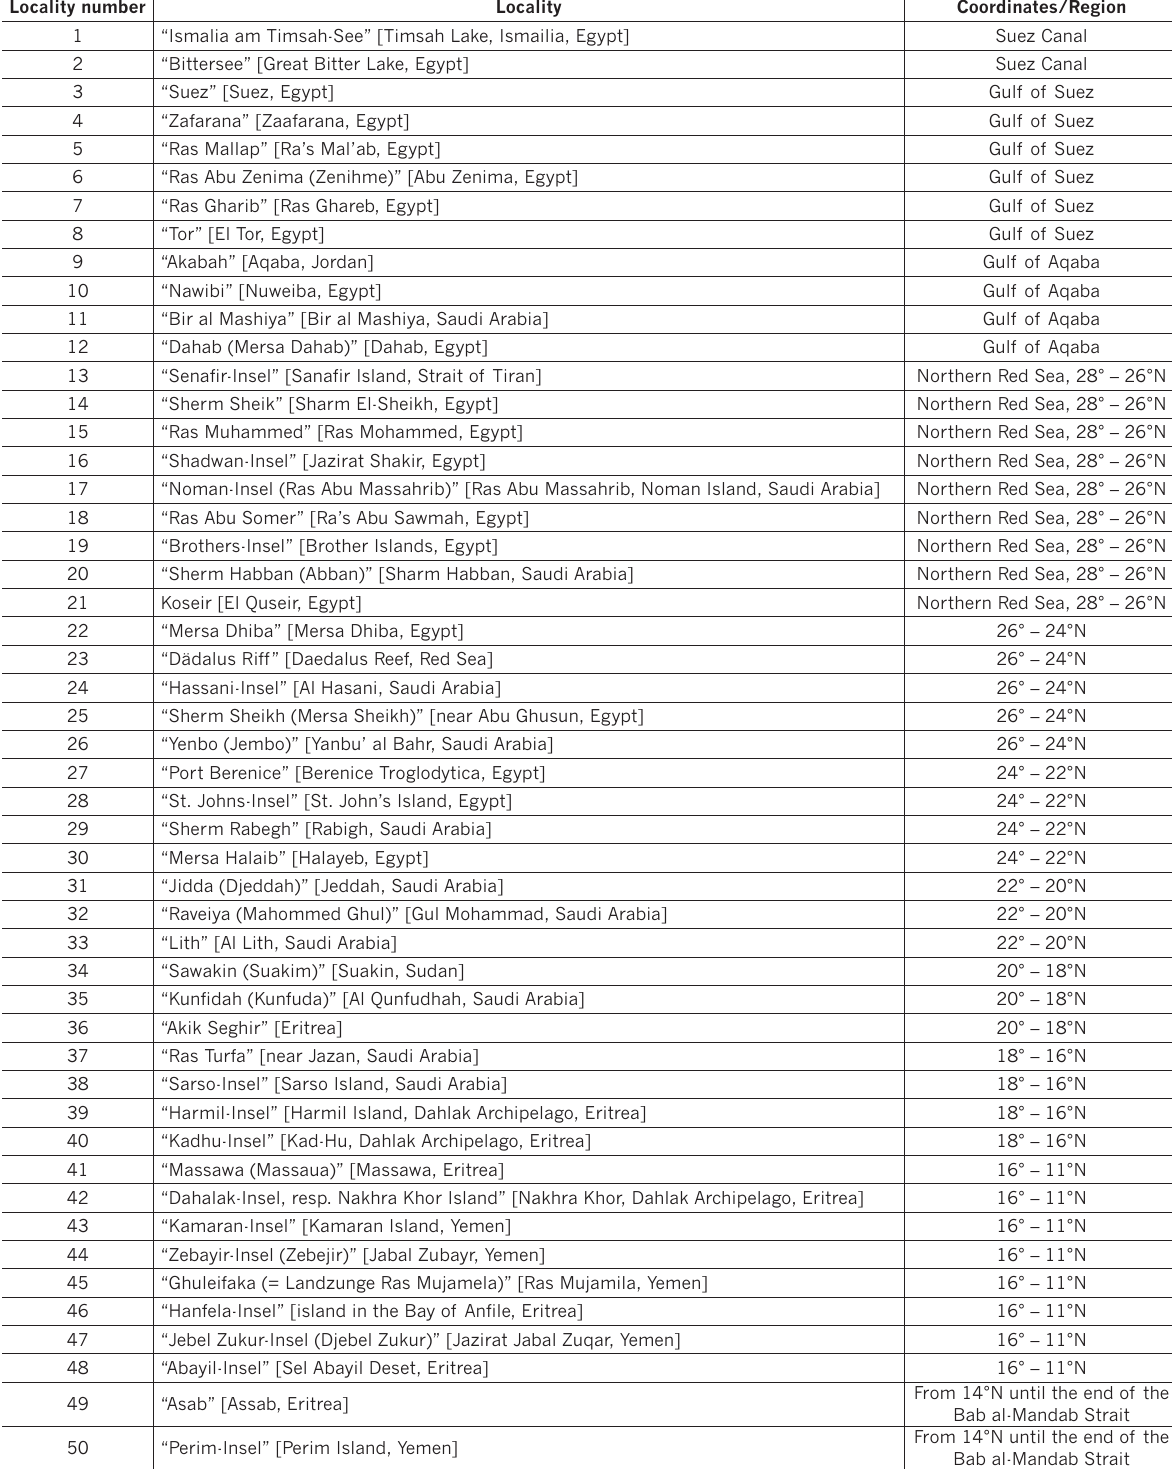
Table 2. Coastal localities of the “Pola” expedition (from Sturany (1903)). Locality